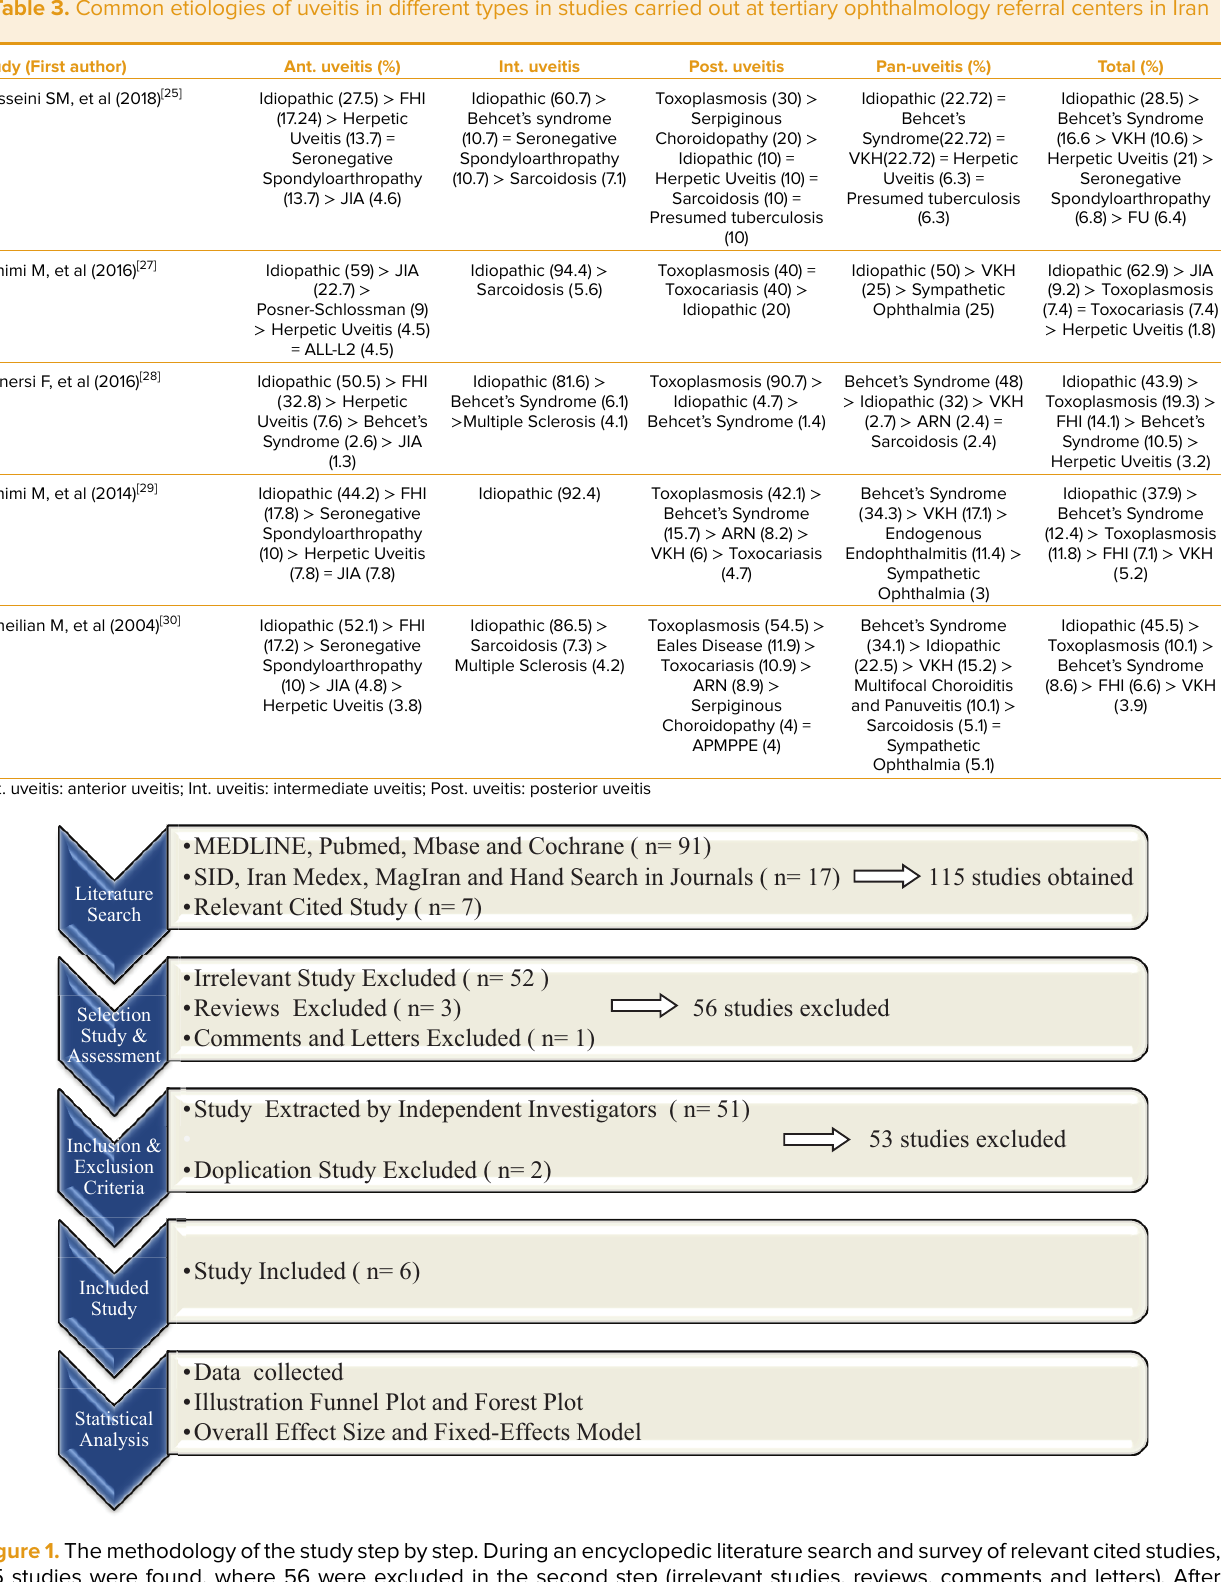
Figure 1. The methodology of the study step by step. During an encyclopedic literature search and survey of relevant cited studies, 115 studies were found, where 56 were excluded in the second step (irrelevant studies, reviews, comments and letters). After reviewing the inclusion and exclusion criteria, 53 more studies were excluded, and finally, 6 studies were included for statistical